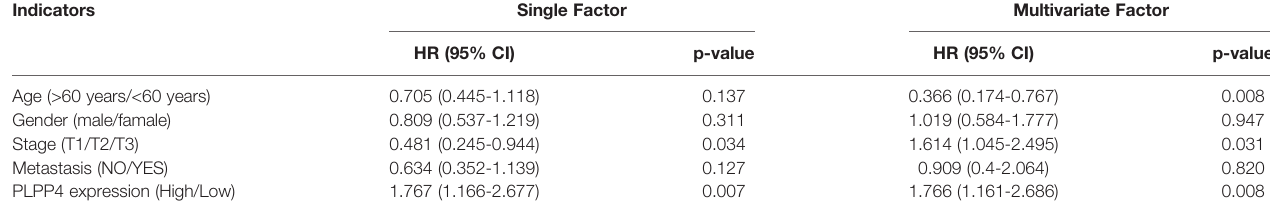
TABLE 3 | Risk factors for survival and prognosis of pancreatic cancer patients by COX proportional hazards model using TCGA date. Indicators